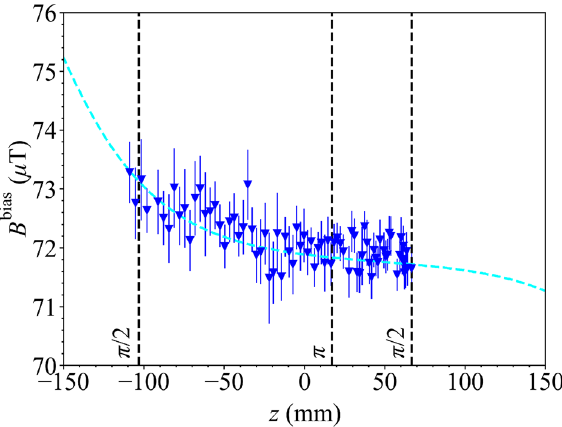
Figure 7. The total bias magnetic field, B bias , generated by the uniform B z coil evaluated along the z -axis of the interferometer using the atoms (dark blue scatter points), and fitted to numerical simulation of the field profile in the interferometer with the atomic package (dashed cyan; COMSOL Multiphysics Version 5.3a). Additional lines (dashed black) show the axial position of the cloud during the interferometry pulses (dashed black; in π/ 2 − π − π/ 2 sequence at distances z = [ 66.9, 17.1, − 103.4 ] mm) as the cloud falls from the MOT ( z = 68.1